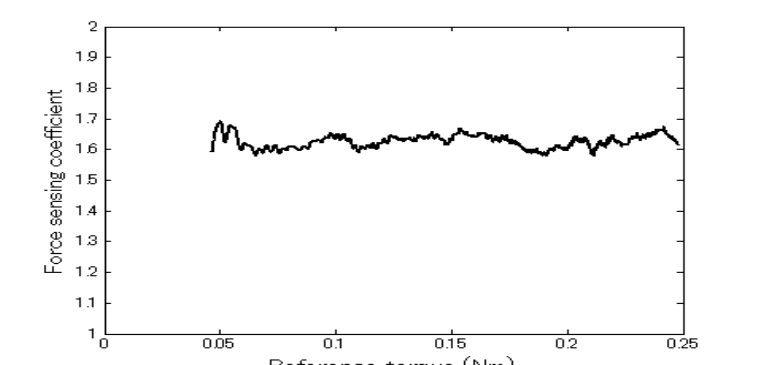
Figure 5. Force sensing coefficient